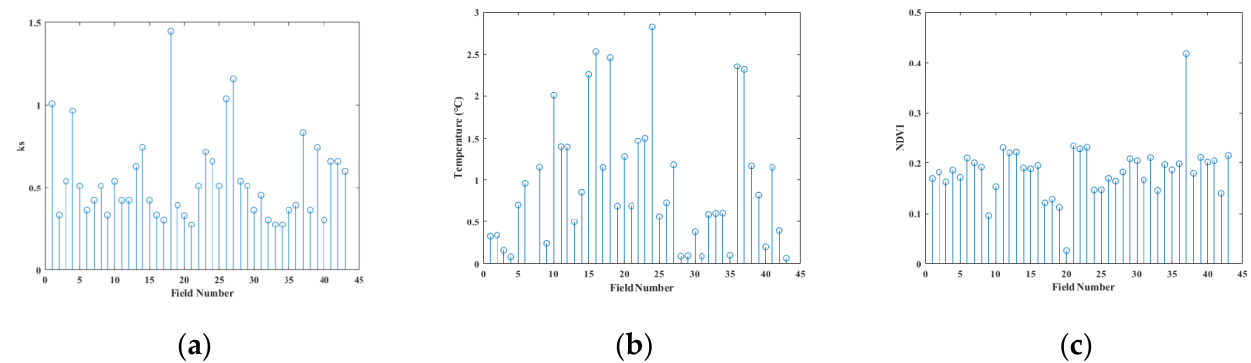
Figure 6. ( a ) Optimized surface roughness, ( b ) Ground measured soil temperature (no temperature data for L07-M13 station), and ( c ) NDVI for 43 ground stations on April 1, 2015.